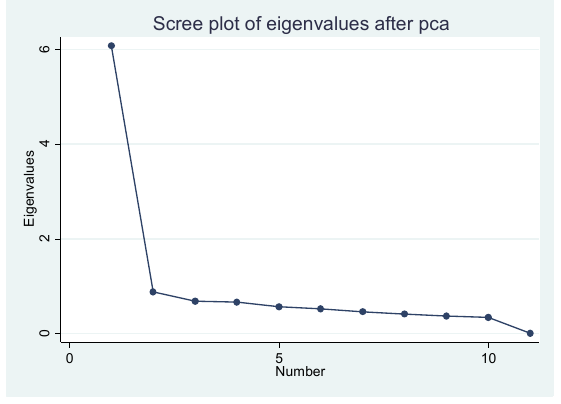
Fig. 3. Screen plot of eigen values